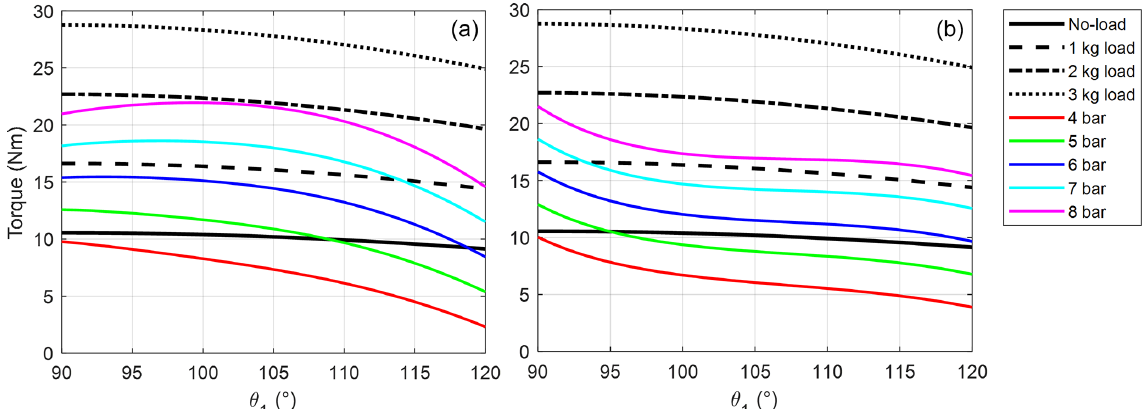
Figure 9. Gravitational torque in no-load (black line) and 1kg (dashed black line), 2kg (dot-dashed black line), and 3kg (dotted black line) loaded conditions as well as torque exerted by the exoskeleton (colored lines) at different supply pressures, by employing the DMSP-10- 100N muscle. The plot in (a) refers to the pulley-based design of the transmission system, while the plot in (b) refers to the cam-based design considering r i = 37mm.